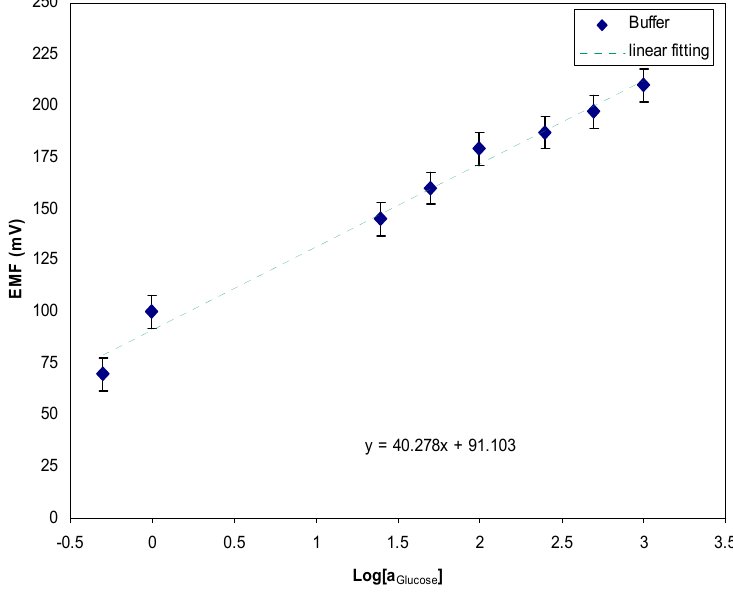
Figure 5. The electrochemical response of microscale biosensor against the logarithmic range of glucose electrolyte